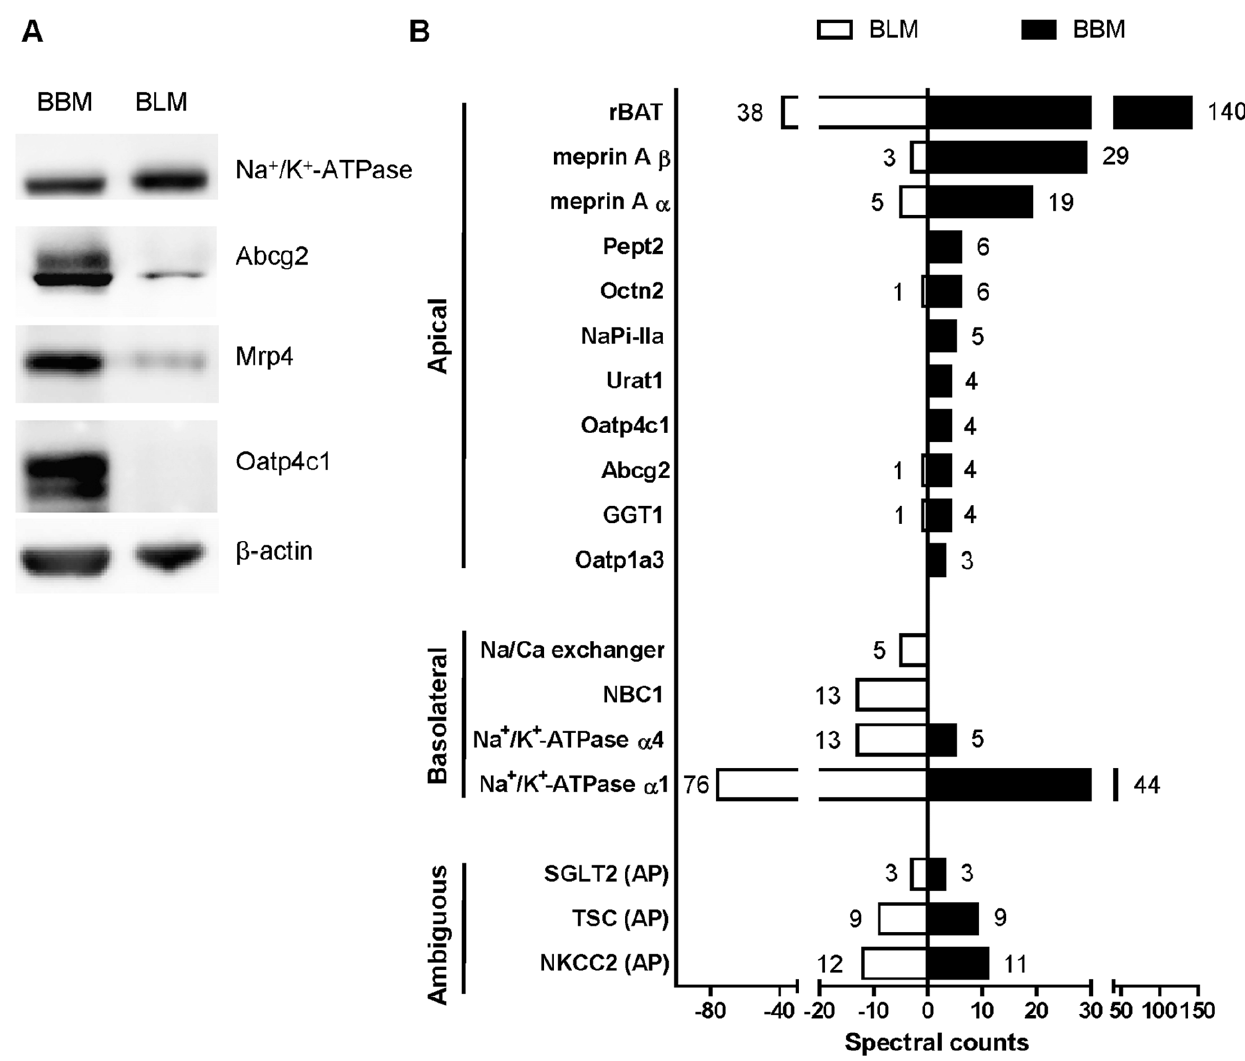
Figure 3. Expression of Oatp4c1 in isolated kidney brush border membrane (BBM) and basolateral membrane (BLM) fractions. (A) Western blot analysis for Oatp4c1 expression in BBM and BLM. Biochemical separation of membrane proteins (20 m g per lane) from rat kidney cortex was achieved by Percoll gradient. Na + /K + -ATPase alpha 1 was used as a basolateral marker. Abcg2 and Mrp4 served as apical markers. Oatp4c1 was detected by PA1343. (B) LC-MS/MS based proteomic analysis of , 60–150 kD proteins isolated from BBM and BLM fractions. Spectral counts detected in protein digests obtained from , 60–150 kD sections excised from the SDS-PAGE gel. Proteins with 3 or more spectral counts in one fraction are presented as ‘‘Apical’’ or ‘‘Basolateral’’ based on previously published data. Spectral counts indicate the number of unique peptides detected in each fraction. (AP, apical).